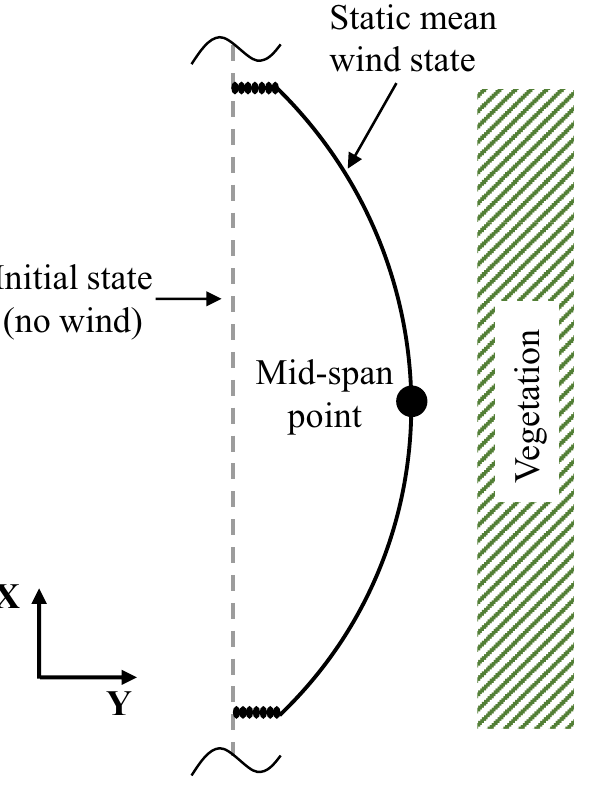
Figure 7. Top view of the lateral clearance within one